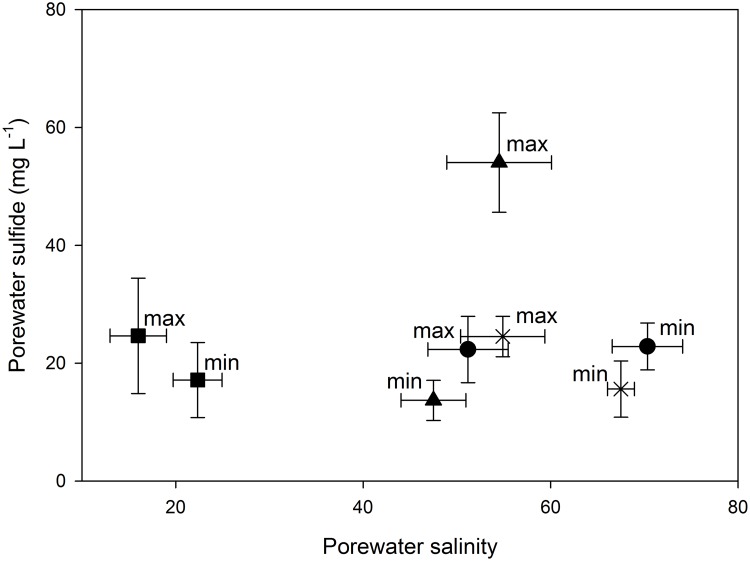
Porewater sulfide vs. porewater salinity in the minimum and maximum floods in the restored site 1–4 (circle), the undisturbed reference site (cross) and other impaired sites (triangle) in Isla del Carmen, Campeche, Mexico.The values represented by the squares are from a conserved mangrove site in South Florida, USA [59].